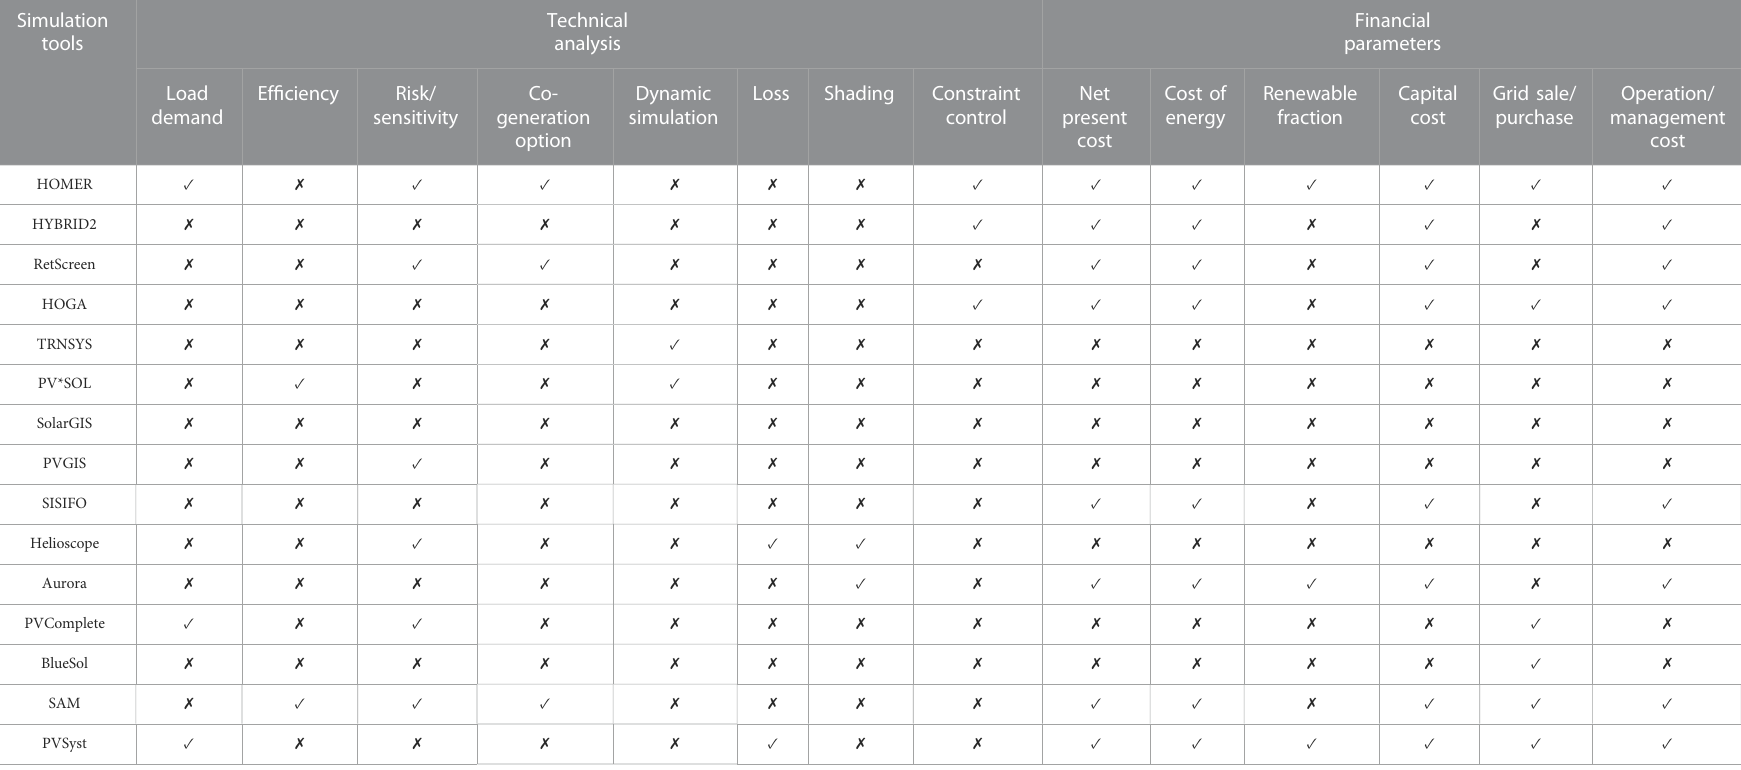
HOMER HYBRID2 RetScreen